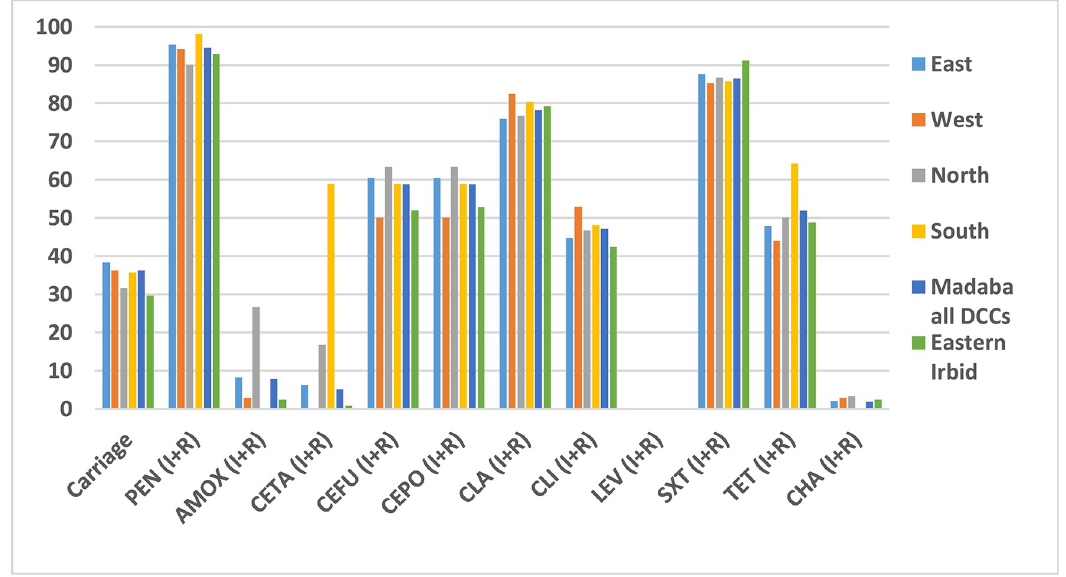
Fig 3. Carriage and resistance rates of Streptococcus pneumoniae isolates from eastern Irbid and all DCCs of Madaba for both winter seasons from October 2017 to End of March 2019. Abbreviations: PEN: Penicillin; AMOX: Amoxicillin; CETA: Cefotaxime; CEFU: Cefuroxime; CEPO: Cefpodoxime; CLA: Clarithromycin; CLI: Clindamycin; LEV: Levofloxacin; SXT: Trimethoprim-sulfamethoxazole; TET: Tetracycline; CHA: Chloramphenicole; I: Intermediate resistance; and R: